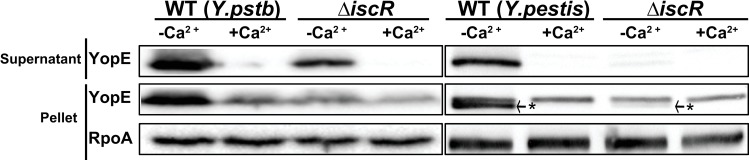
IscR is critical for type III secretion in Y. pestis.WT and ΔiscR Y. pseudotuberculosis (pstb) and Y. pestis pgm- were grown in BHI low calcium or high calcium media at 37°C. Proteins in the bacterial culture supernatant were precipitated with TCA and type III secretion probed using an anti-YopE antibody. Results are representative of three independent experiments. * YopE specific band. Doublet bands for YopE have been previously reported [58].